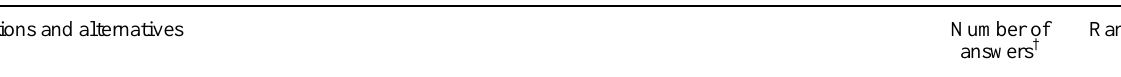
Table 2 . Overview of the results of the one-time survey. Questions and